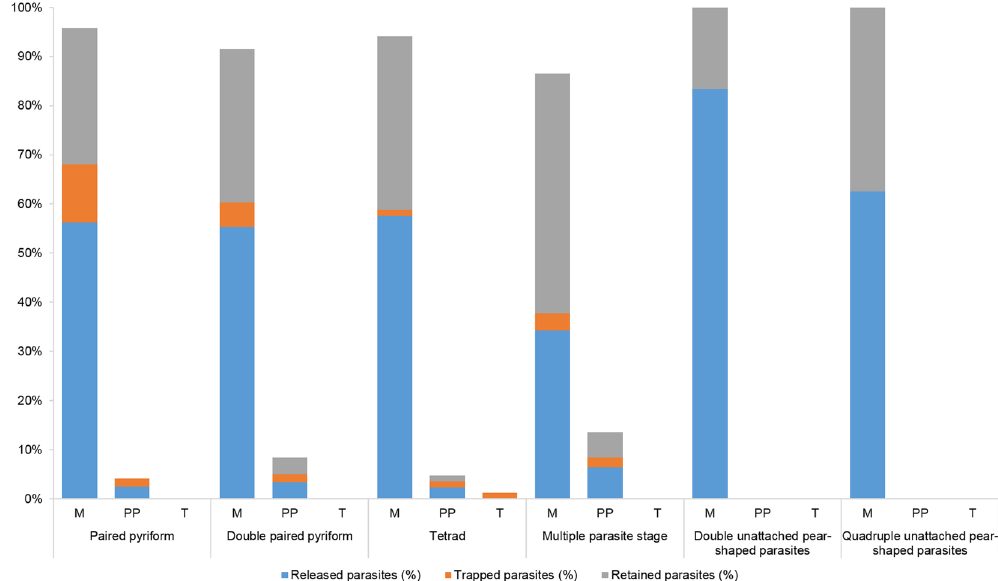
Figure 5. The egress efficiency of B. divergens was determined by the rate of parasite yield by the intraerythrocytic stages during the process. The graph shows the percentage of released, trapped and retained parasites within the infected erythrocytes: merozoite (M), paired pyriforms (PP), tetrads (T), n values were: n = 88 paired pyriforms, n = 71 double paired pyriforms, n = 23 tetrads, n = 76 multiple parasites stages, n = 3 double unattached pyriform parasites, n = 4 quadruple unattached pyriform